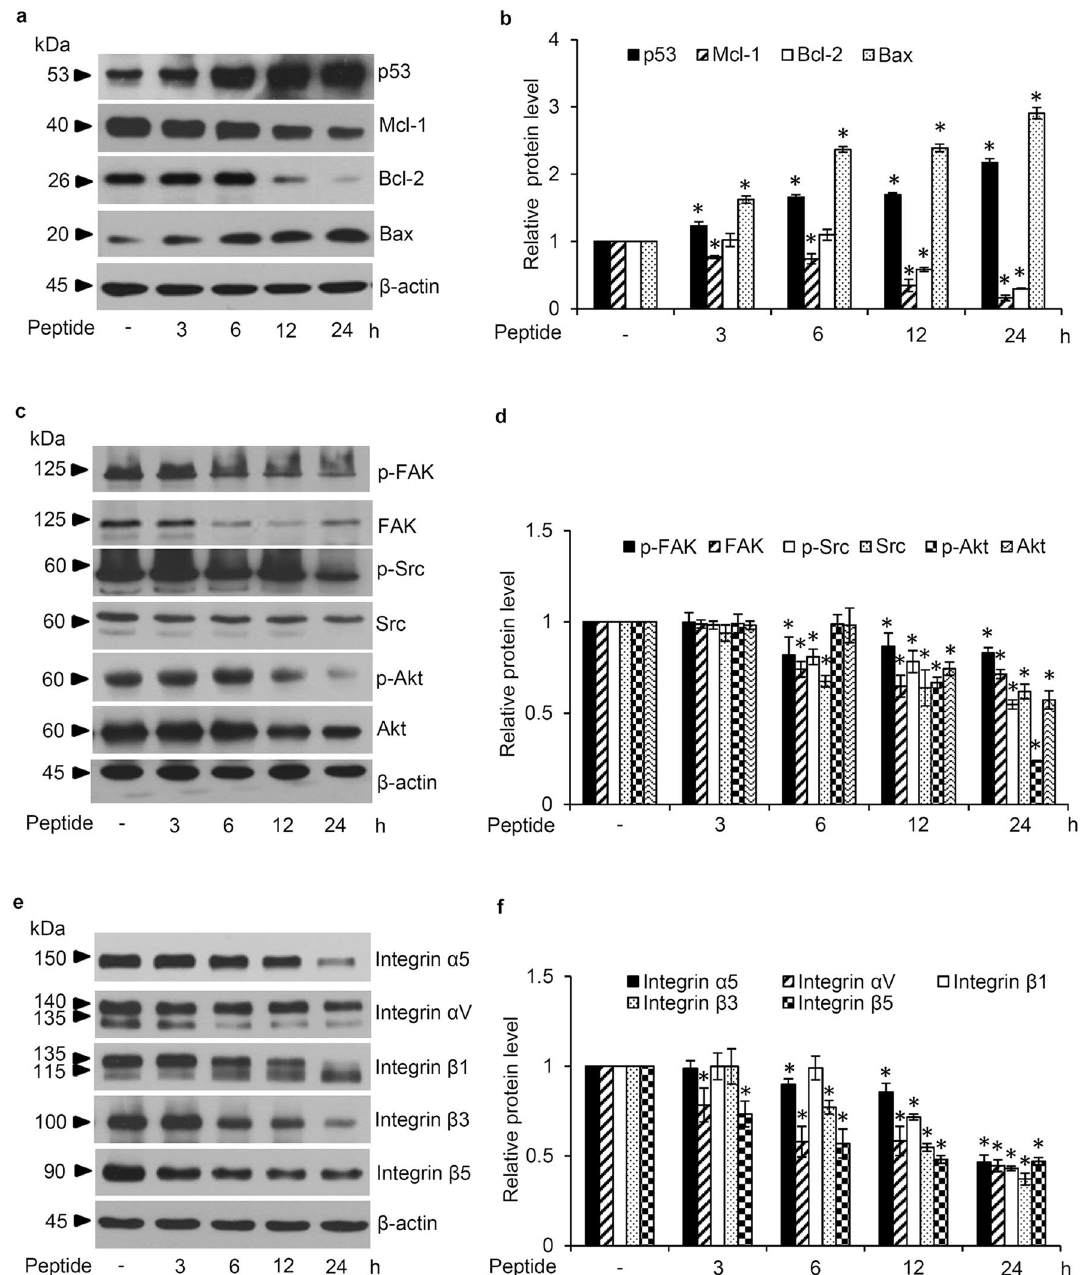
Figure 4. L. squarrosulus peptide modulates apoptosis and survival pathway in human lung cancer cells. ( a ) Western blot analysis revealed the reduction of anti-apoptosis proteins (Mcl-1, Bcl-2) in H460 cells cultured with 5 µg/mL of L. squarrosulus peptide from 0.4 M NaCl fraction for 12–24 h. ( b ) However, the significant upregulation of p53 and pro-apoptosis Bax protein was observed after 3 h of peptide treatment. The downregulation of ( c ) survival proteins and ( e ) upstream regulatory molecules, integrins, was also detected in L. squarrosulus peptide treated-cells. ( d ) The expression level of survival p-FAK, FAK, p-Src, Src, p-Akt and Akt protein was time-dependently decreased which corresponded with (f) the diminution of integrin β1, β3, β5, αV and α5 in H460 cells incubated with 5 µg/mL of 0.4 M NaCl peptide. Values are means of three independent experiments ± SD. * p < 0.05 versus non-treated control